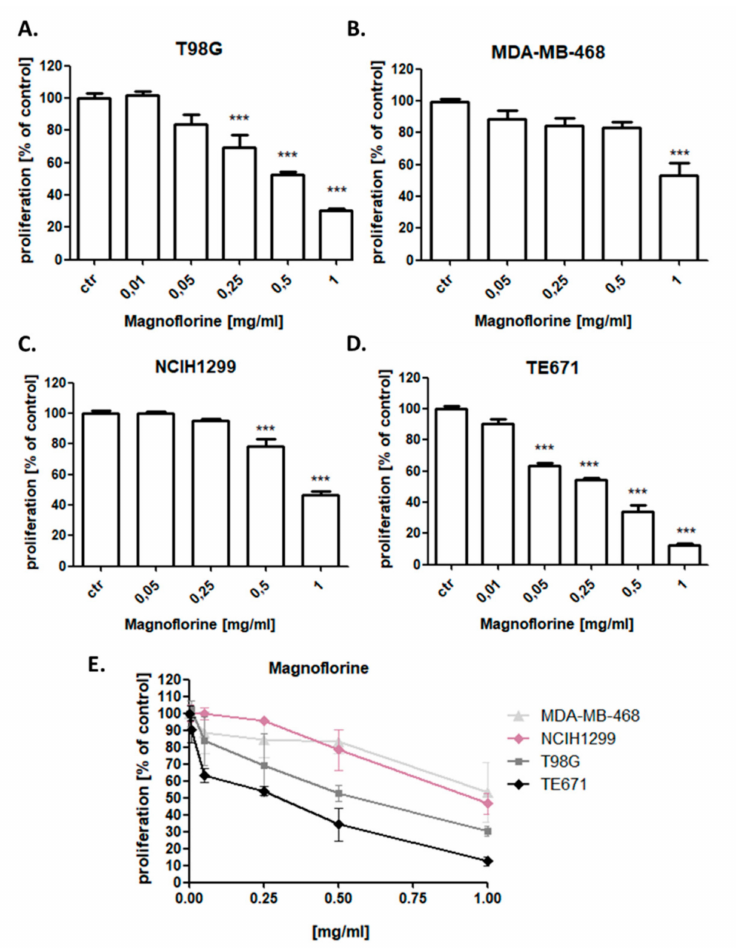
Figure 4. E ff ect of magnoflorine (MGN) on the proliferation of T98G glioma ( A , E ), MDA-MB-468 breast ( B , E ), NCIH1299 lung ( C , E ), and TE671 rhabdomyosarcoma ( D , E ) cancer cells in 5-bromo-2 (cid:48) -deoxyuridine (BrdU) assay. Cancer cells were incubated for 48 h alone (control)